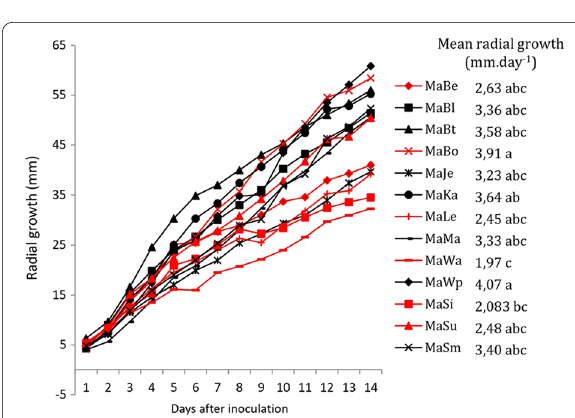
Fig. 2 Radial growth rate of 13 Metarhizium isolates during 14 days cultured in potato dextrose agar. Mean radial growth value with different lowercase letters denote significant differences (ANOVA, Tukey’s test, P 0.05) ≤